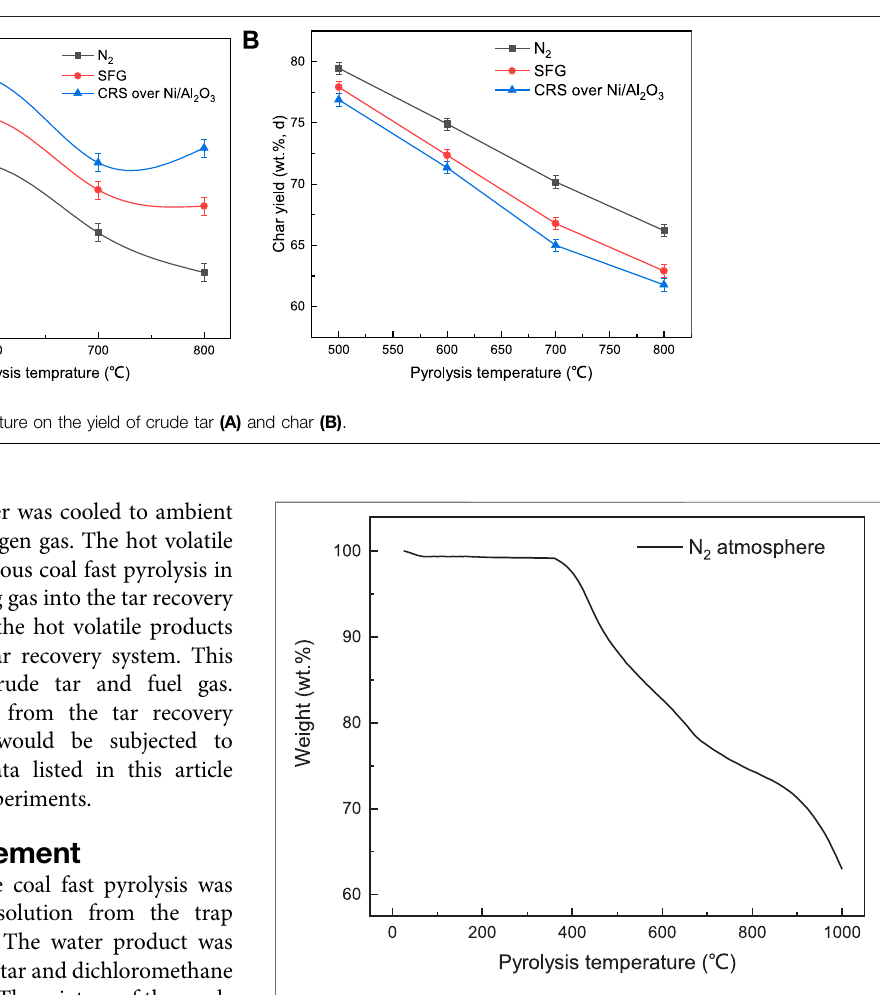
FIGURE 3 | TGA pro fi les of bituminous coal under the N 2